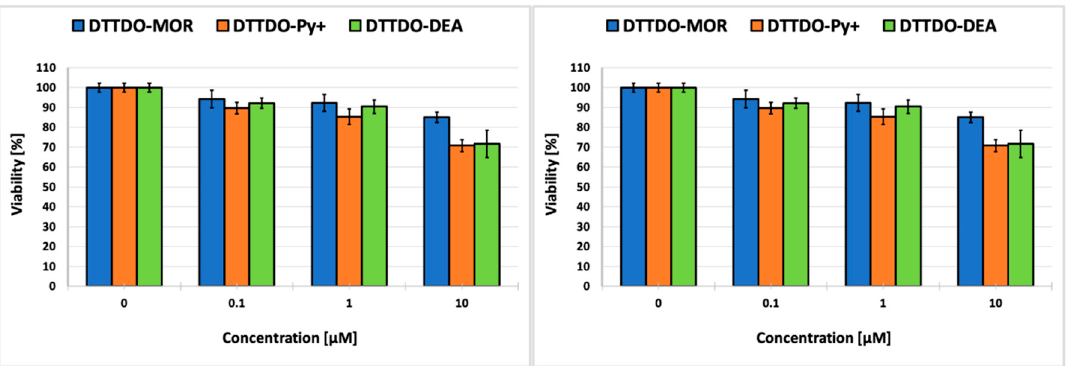
Figure 8. Cytotoxicity of tested compounds for human epidermoid squamous carcinoma cells (A431) ( left panel) and human keratinocytes ( right panel) after 24 h incubation. Results represent the mean cell viability calculated with reference control (cells treated with DMSO—100% viability).